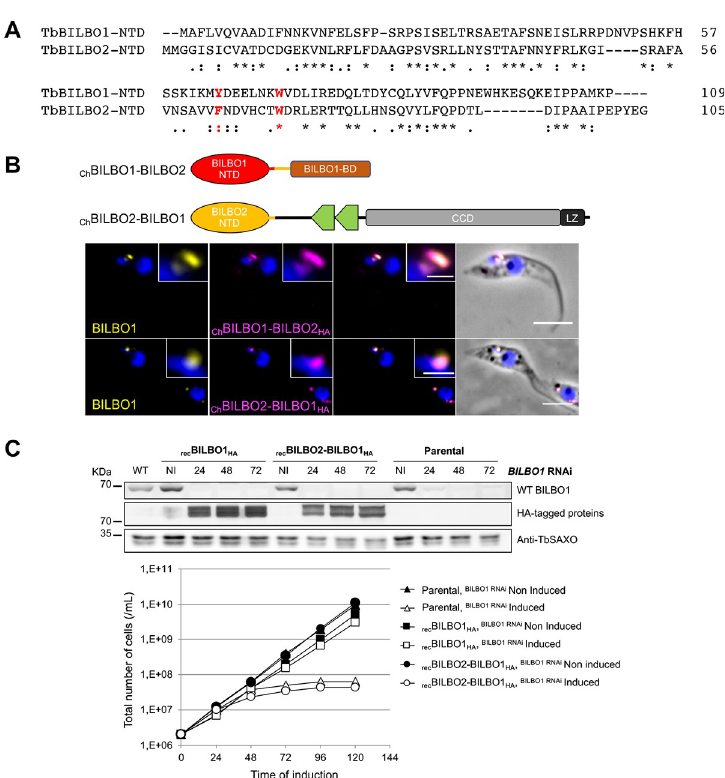
Fig 5. BILBO1 and BILBO2 share a conserved N-terminal domain with conserved residues. A. Alignment of the BILBO1 and BILBO2 NTD domains. Asterisks indicate identical residues; colons indicate conserved substitution; periods indicate semi-conserved substitutions. B. Immunolocalization of chimeric BILBO1-BILBO2 proteins. Anti- BILBO1 labels both BILBO1 and Ch BILBO1-BILBO2 HA ; anti-HA labels Ch BILBO1-BILBO2 HA or -1 tetracycline and detergent-extracted for immuno- Ch BILBO2-BILBO1 HA . Cells were induced 18h with 1 μ g.mL labelling. Scale bars represent 5 μ m. C. Cells inducible for BILBO1 RNAi and for the expression of recoded -1 of tetracycline. The parental cells are inducible for rec BILBO1 HA or rec BILBO2-BILBO1 HA were induced with 2 μ g.mL BILBO1 RNAi only. Top panel: Western blot analysis of whole cells non induced or induced at different time points. Anti-TbSAXO was used as loading control. Bottom panel: Growth curves of non-induced and induced cells showing that rec BILBO1 HA can rescue the RNAi growth defect, contrary to rec BILBO2-BILBO1 HA .